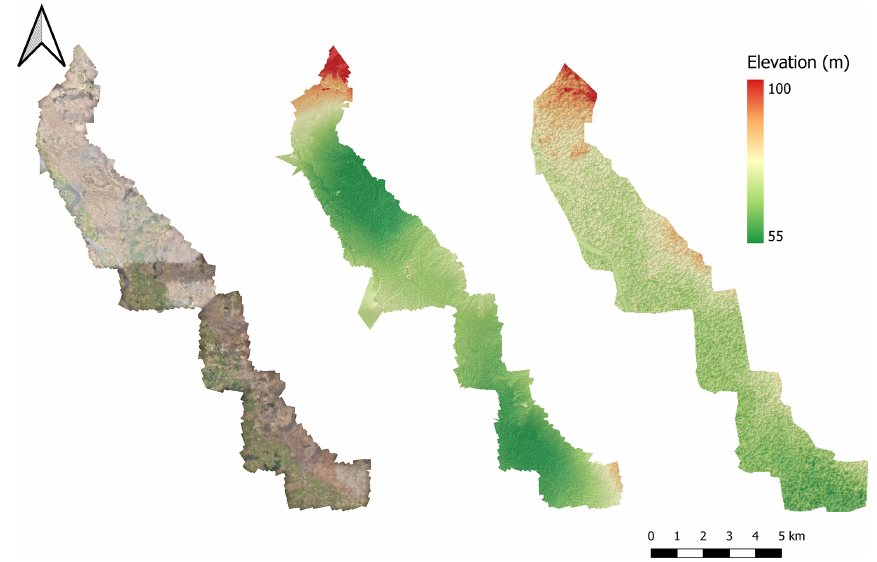
Figure 7. Example of the orthophoto (left) and DSM (middle) with shaded relief, produced with images from the UAV flight, and a Shuttle Radar Topography Mission DEM (right) with shaded relief. Made in QGIS using UAV imagery collected by the Malawi Red Cross Society (MRCS).